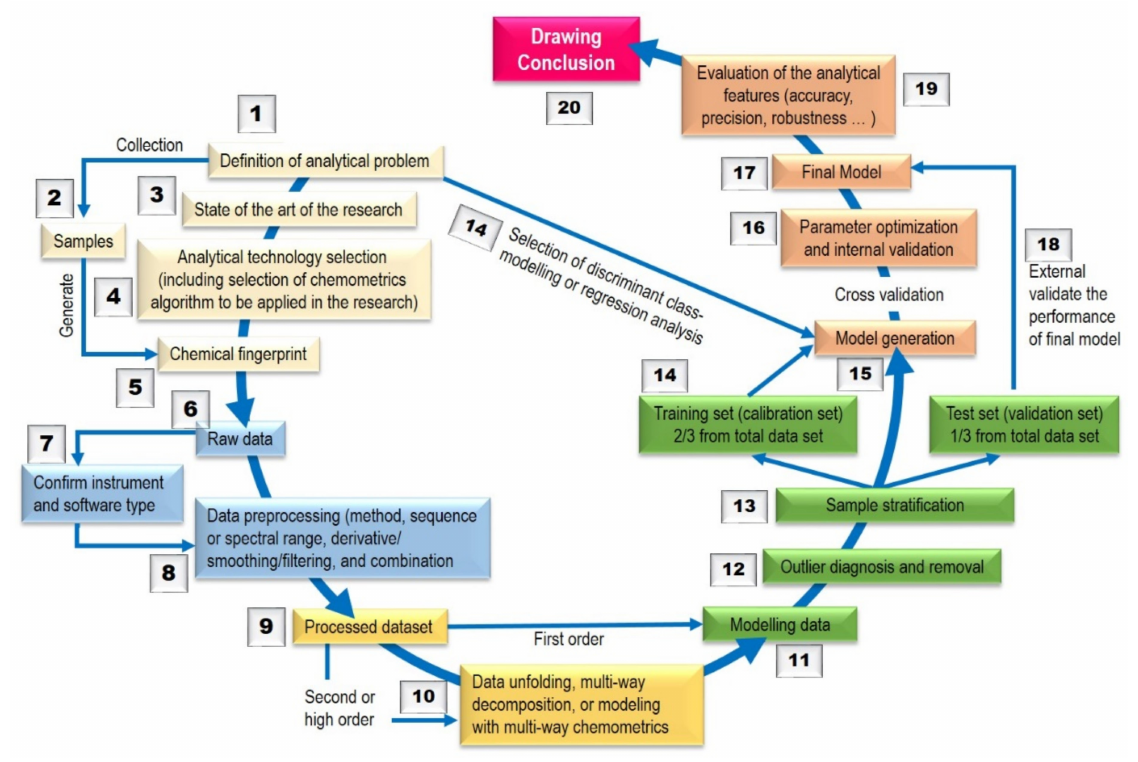
Figure 1. General analytical flow of chemometrics modelling. Adapted from